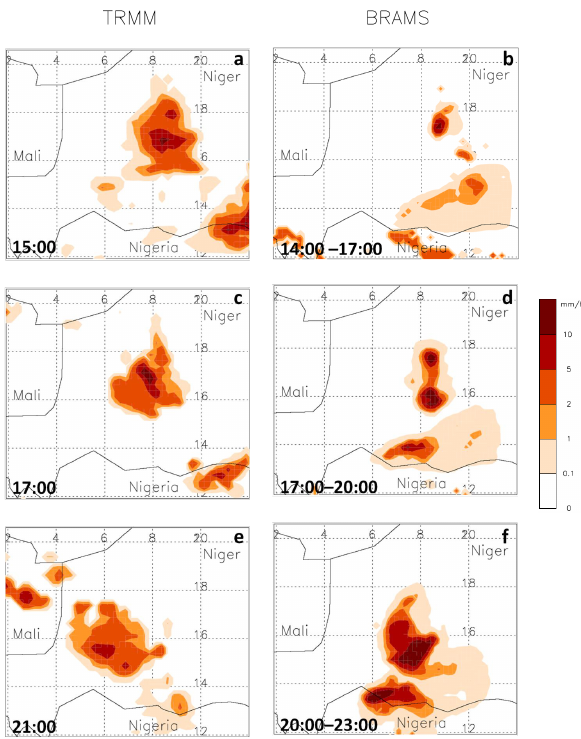
Fig. 10. Comparison between TRMM ( a, c, e ) and BRAMS ( b, d, f ) surface rainrate accumulated over 3 h periods for the A¨ırcase. Panel